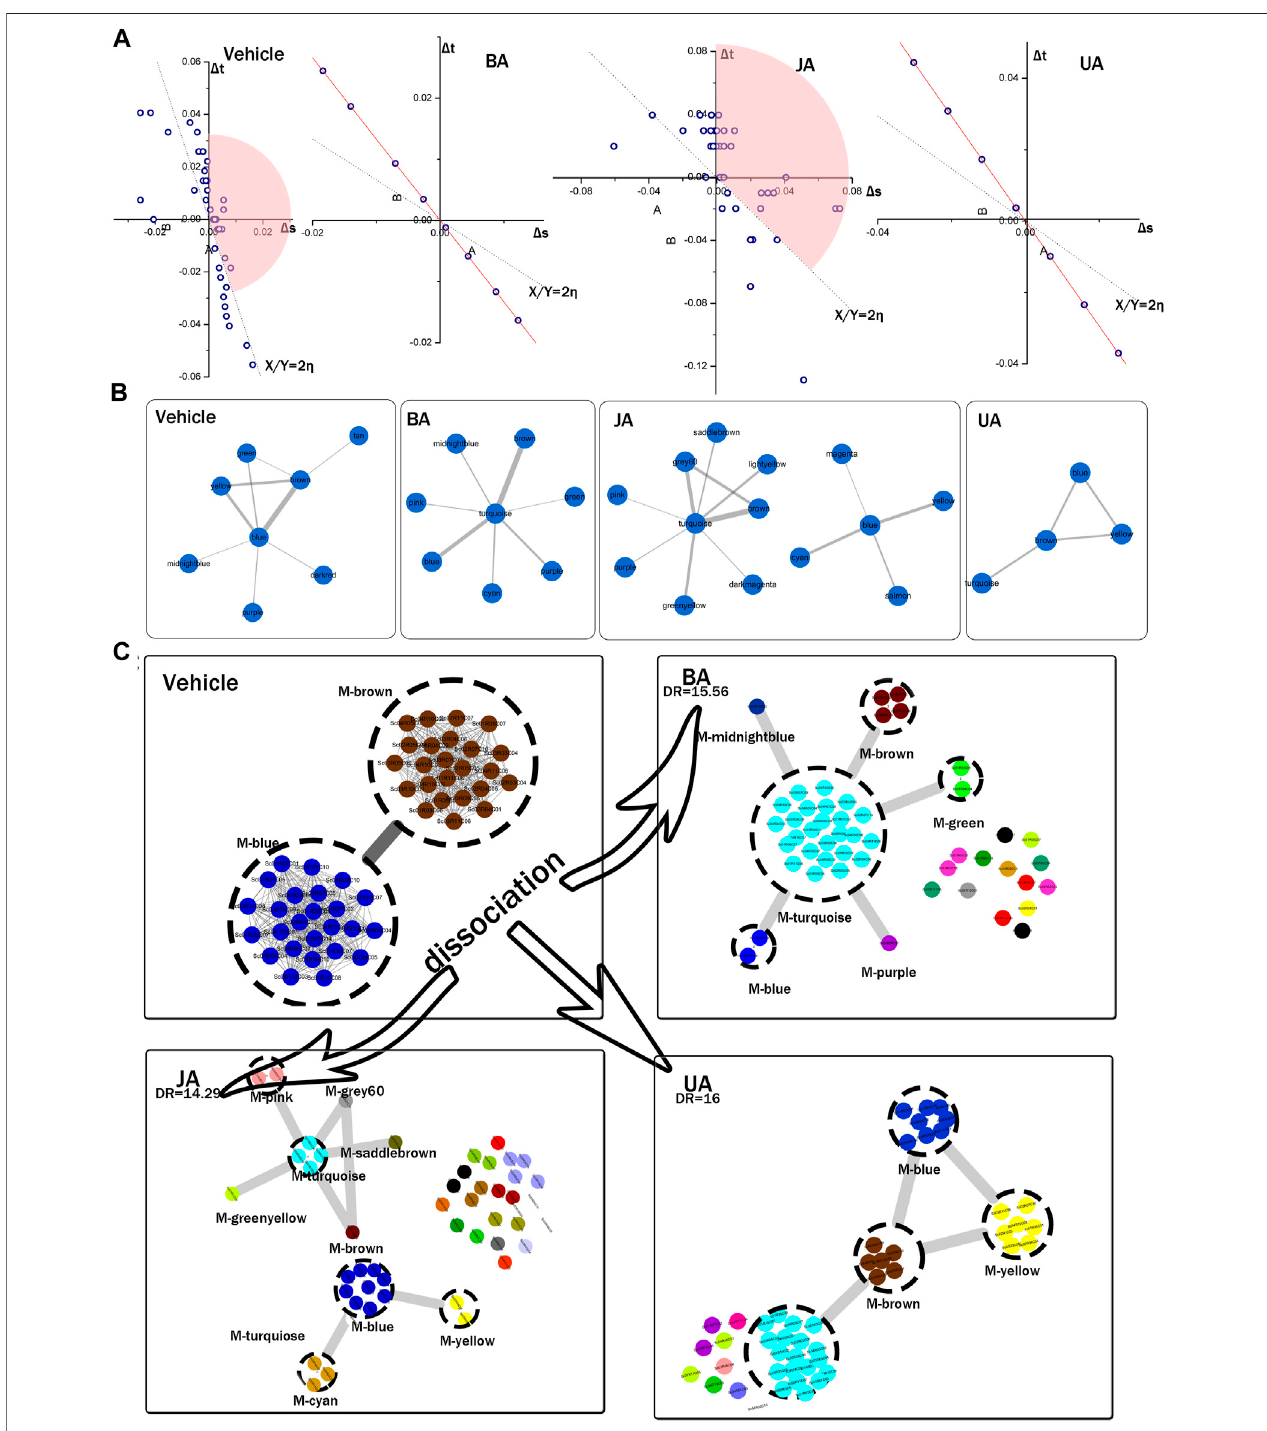
FIGURE4| Identi fi cationofconnectorsanddissociationofpathologicalmodulepair. (A) Connectorsidenti fi edbyvariationofratioofcharacteristicpathlengthand density (VRCD).The Δ sand Δ trepresentthevariationratioofcharacteristicpathlengthtonetworkdensity, η representsaverageratioof Δ sand Δ t.The2-fold changeof η , shown asdottedlinear,wasset ascutoff. Modules in thepink sector domains were identi fi ed asconnectors. Noneof modules were identi fi ed asconnectorin BAand UA groupsfortheir clique-like structure withequal η ofall modules (redline). (B) Connectorsub-network identi fi edbyedge weight distribution. (C) Local dissection of cooperative pathological module pair (PMP). Genes of PMP in vehicle were scattered into different modules in BA-, JA-, and UA-treated groups. Each dashed circle represents a module; circles with the same color in the same region indicate genes in the same module; gray rough lines represent the inter-module connections; gray thread lines represent the interactions between